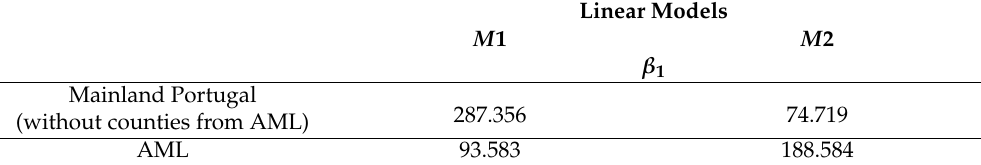
Table 1. Linear models coefficients fit to data from AML and the rest of mainland